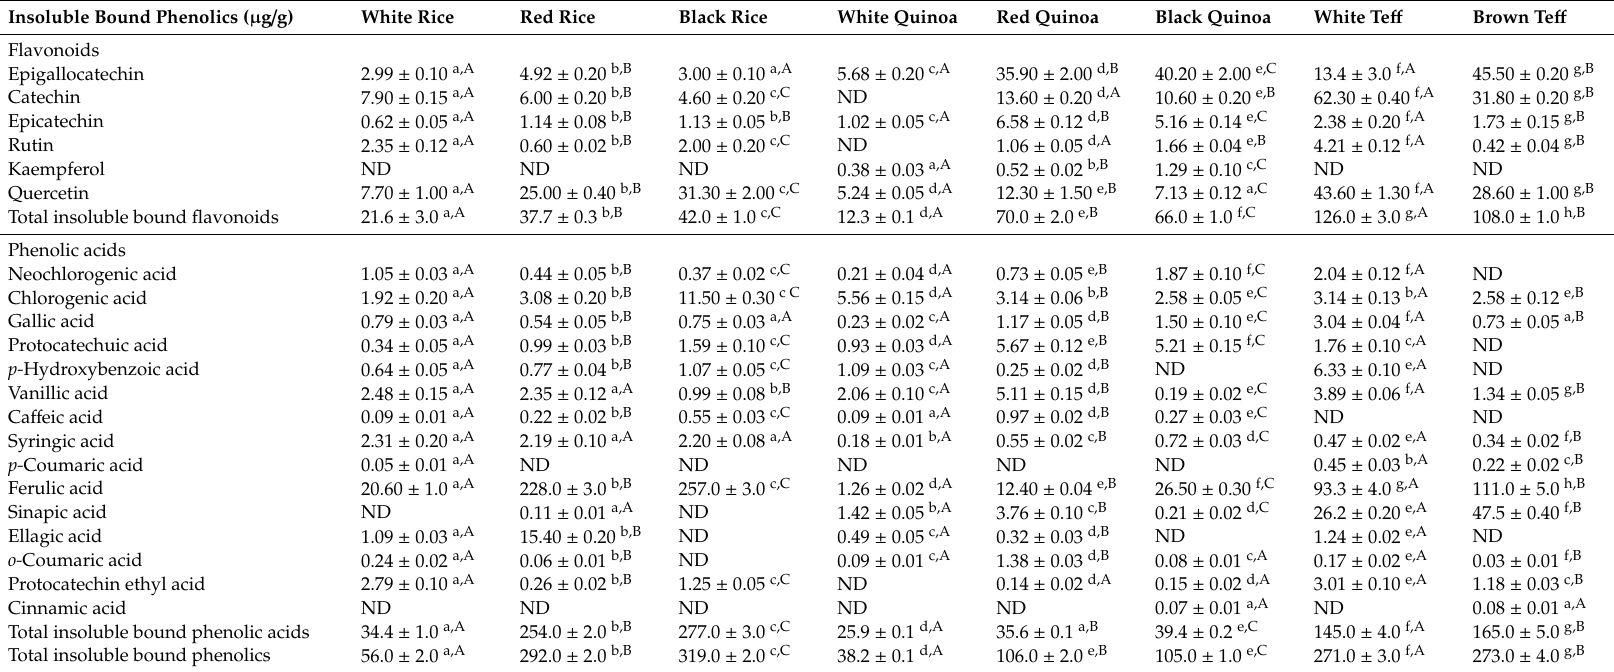
Table 6. Results of individual phenolic concentrations in insoluble bound phenolic fractions of non-traditional